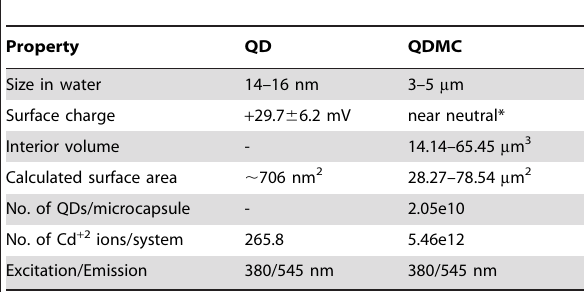
Table 1. QD and QDMC characterization